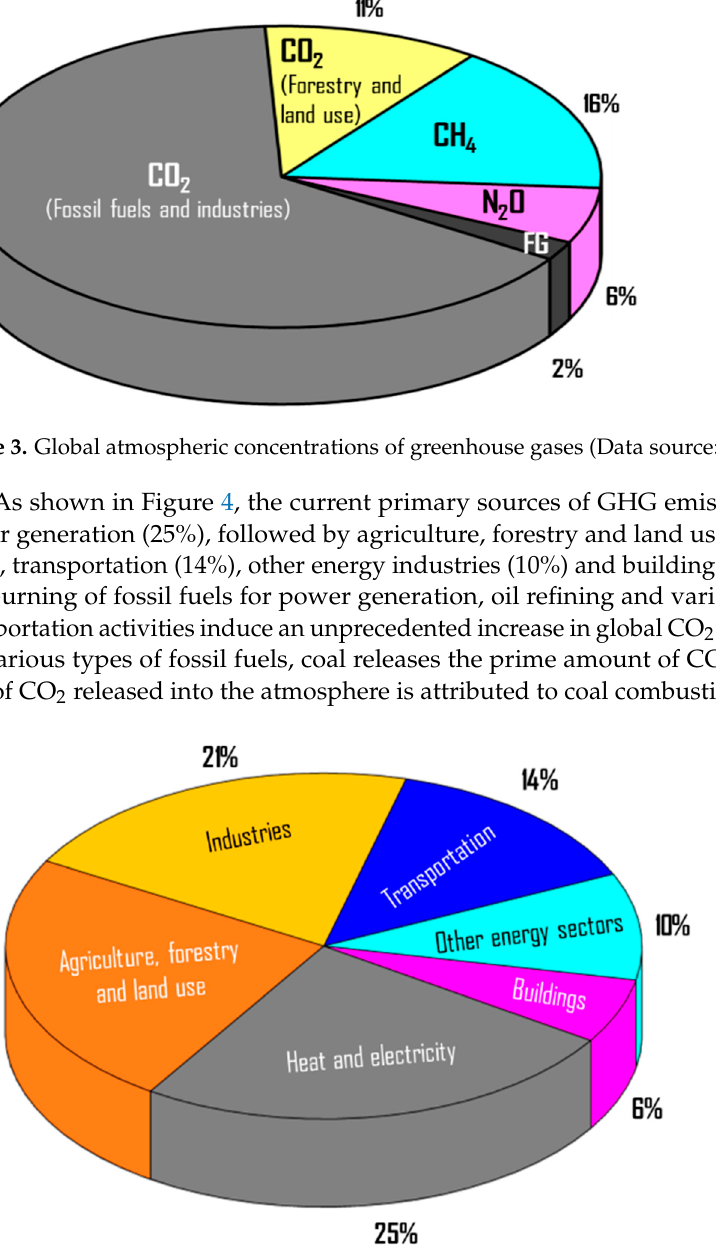
Figure 4. Global greenhouse gas emissions by sectors (Data source: [13]).